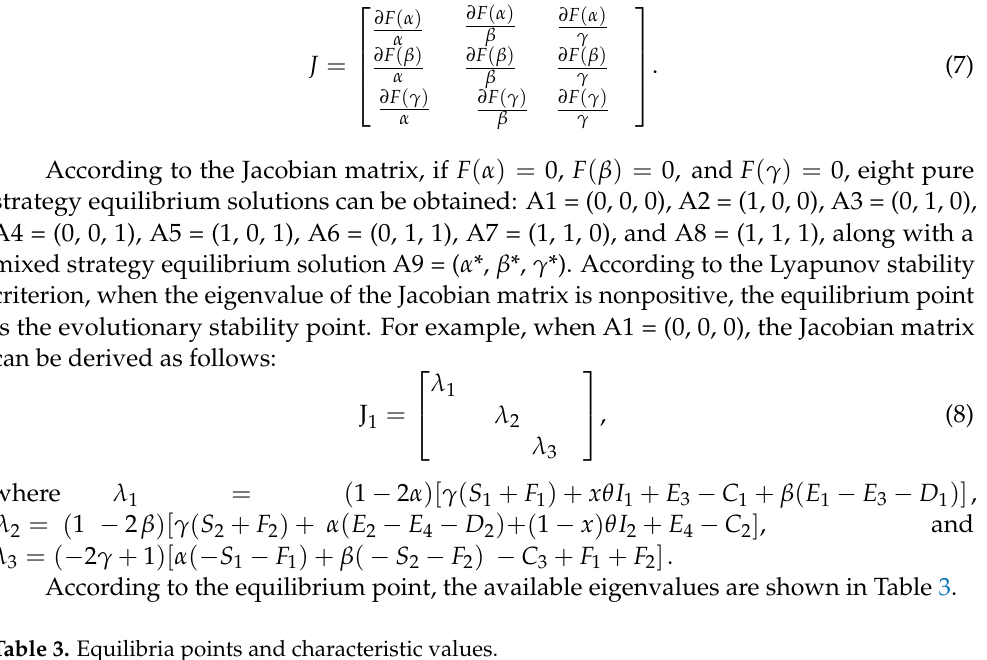
Table 3. Equilibria points and characteristic